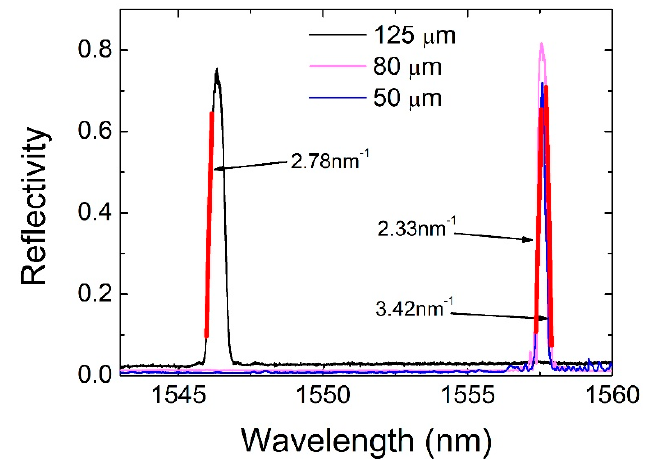
Figure 3. Calibrated reflection spectra of the FBGs inscribed in 125, 80 and 50 μ m-diameter optical fibers.